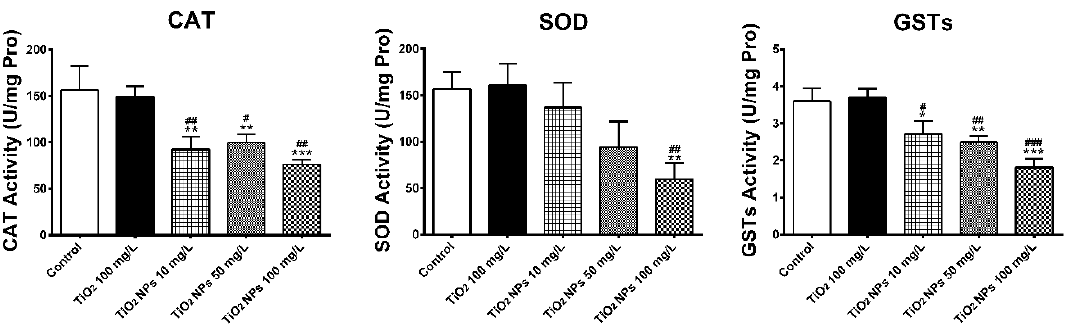
Figure 3. CAT, SOD and GSTs activities in zebrafish gill tissues. Data are expressed as means ± SD ( n = 3). *, ** and *** indicate statistically significant differences from control values at p < 0.05, p < 0.01 and p < 0.001, respectively. #, ## and ### indicate statistically significant differences from TiO 2 (100 mg/L) values at p < 0.05, p < 0.01 and p < 0.001, respectively.